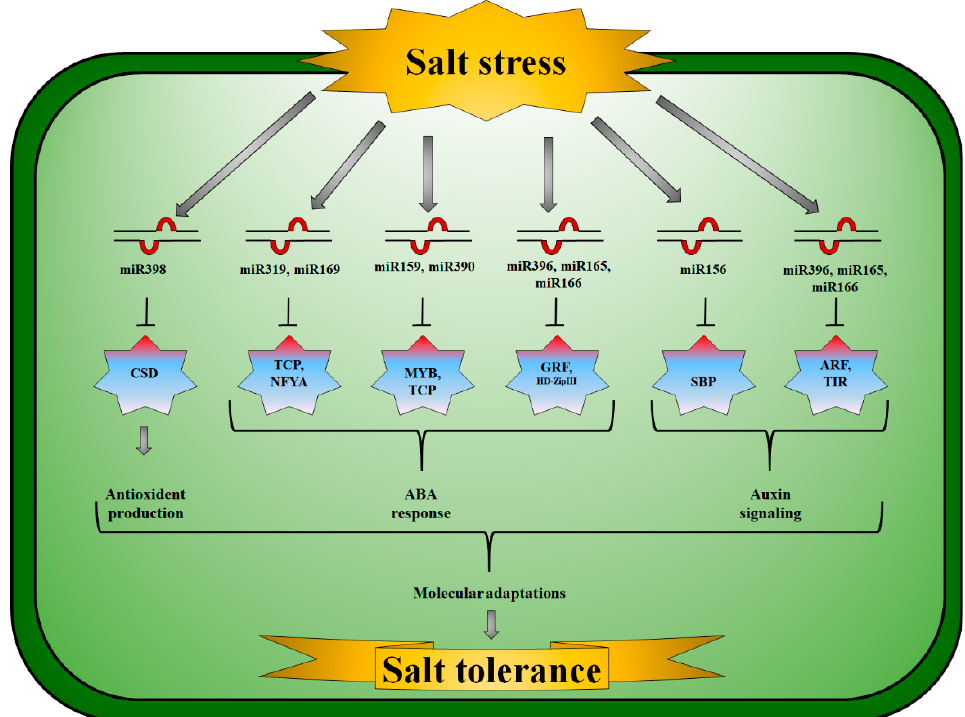
Figure 1. Salt-responsive microRNA and their corresponding targets and signaling pathways in plants. miR398/ CSD (Copper superoxide dismutase) module produces antioxidants, miR319/ TCPs (Teosinte branched1/Cycloidea/Proliferating cell factor) , miR169/ NFYA (Nuclear factor Y subunit A) , miR159/ MYBs (Myeloblastosis) , miR390/ TCPs , miR165/miR166/ HD-Zip (Homeodomain-leucine zipper proteins) , and miR396/ GRF (Growth-regulating factors) module are key ABA-responsive elements. miR156/ SBPs (Squamosa promoter binding protein) , miR165/miR166/ TIR (Toll/Interleukin receptor) , and miR396/ ARF (Auxin response factors) modules play vital roles in auxin signaling to initiate molecular response to tolerate salinity in different plant species.